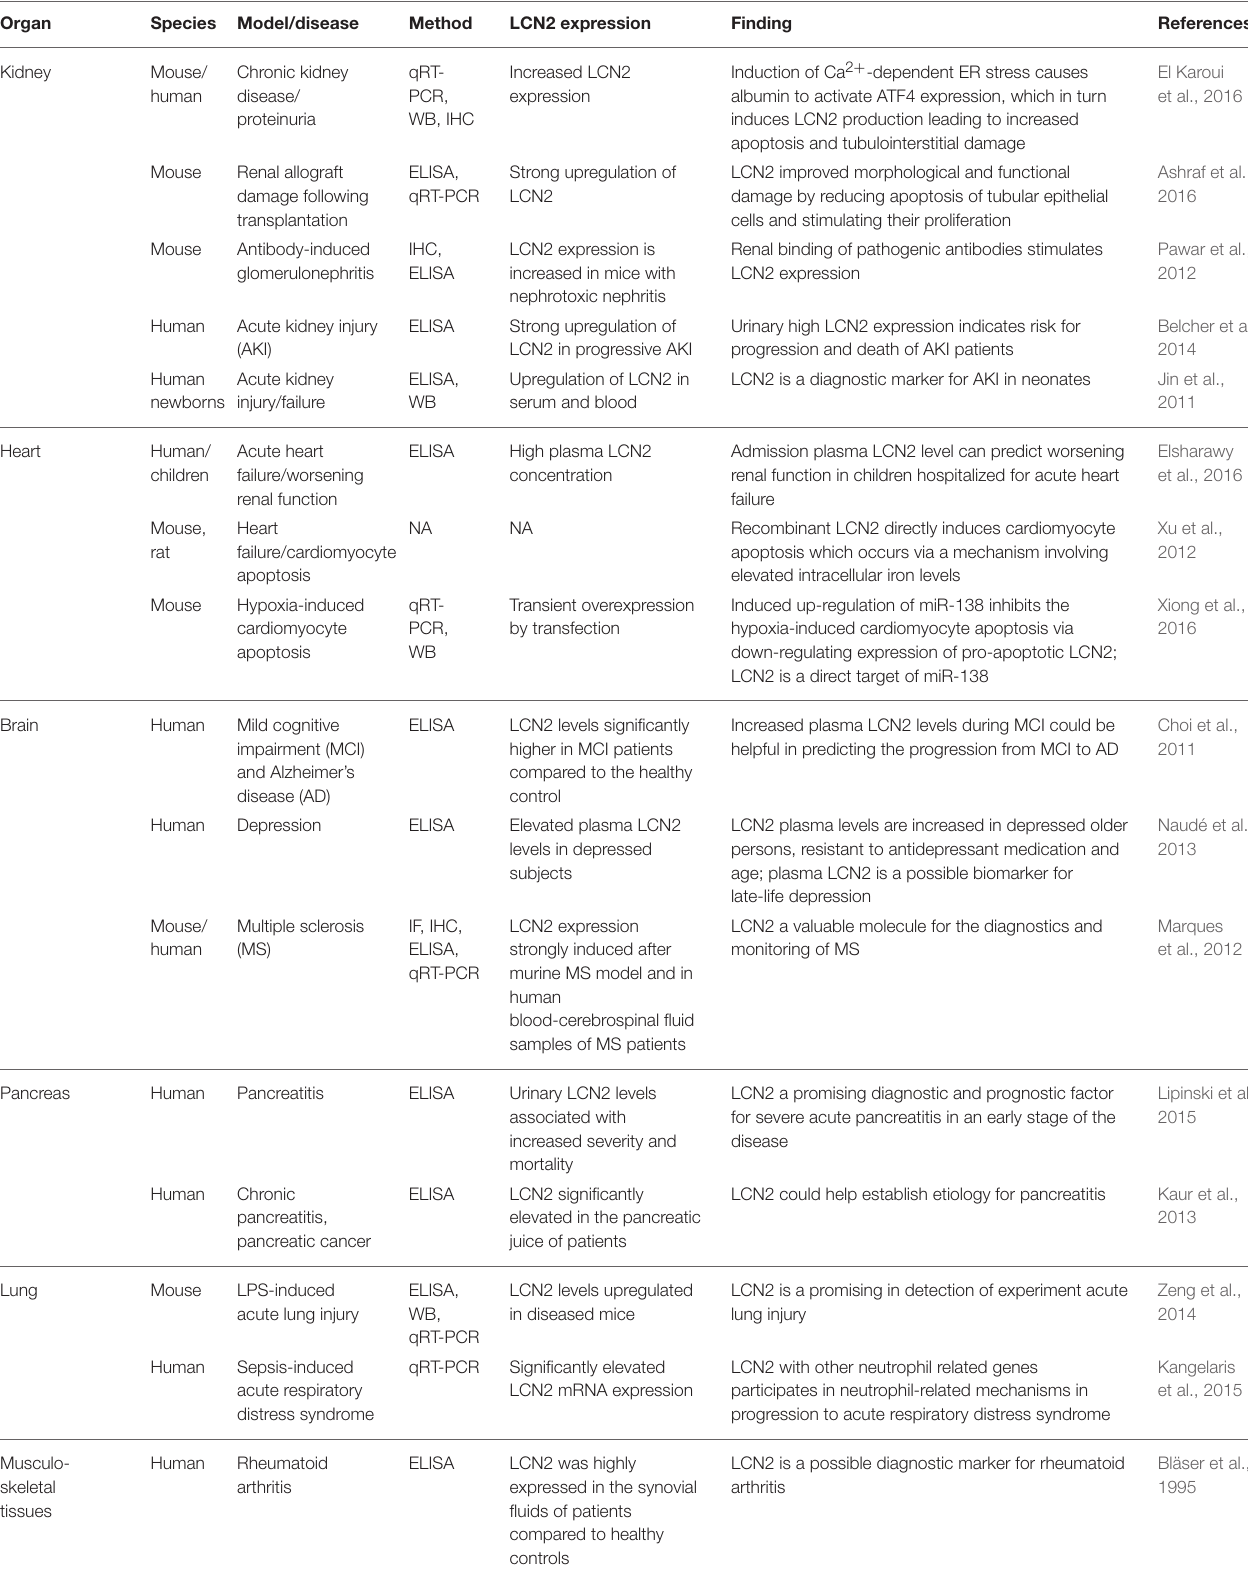
TABLE 2 | Selected experimental and clinical findings associated with altered LCN2 expression in organ disorders.